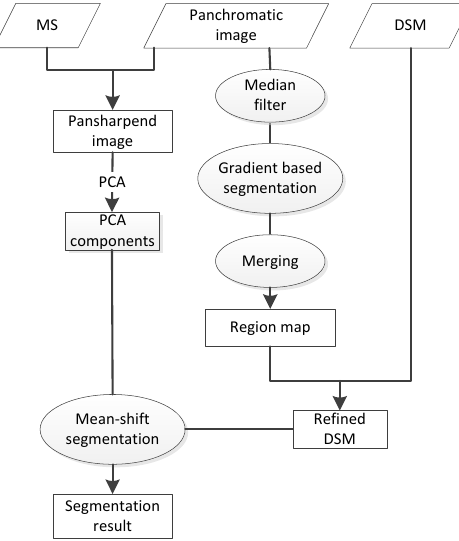
Figure 1. Workflow of the segmentation